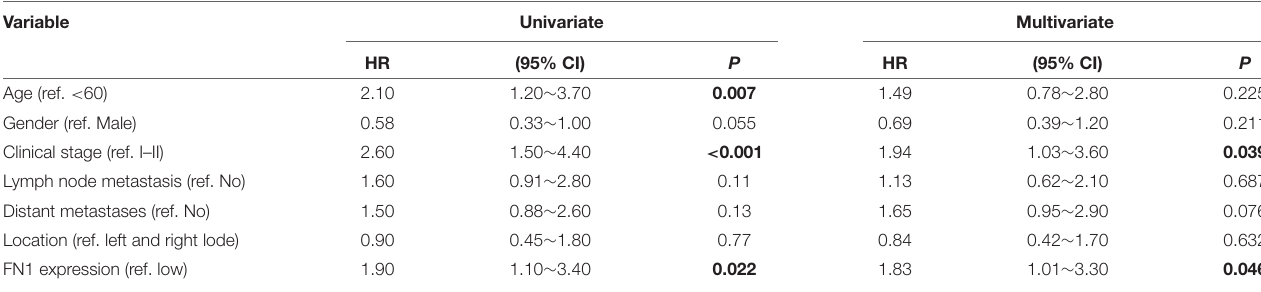
TABLE 4 | Univariate and Multivariate Cox logistic regression analysis of FN1 for predicting PFS in TCGA cohort (PFS, progression free survival; TCGA, The Cancer Genome Atlas). Variable